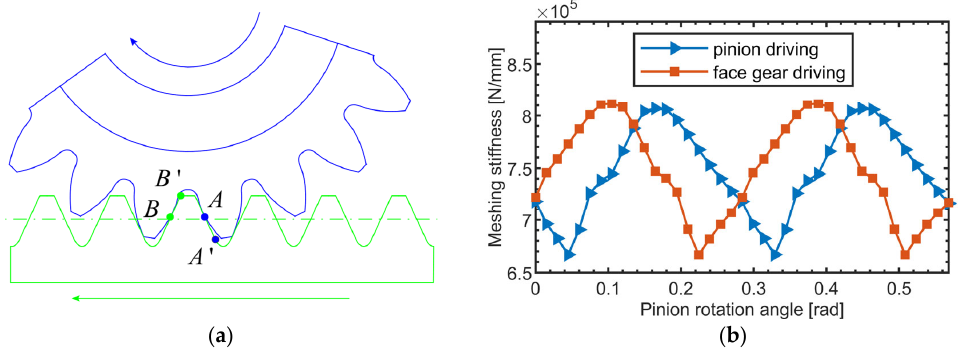
Figure 8. Di ff erence in meshing sti ff ness between face gear driving and pinion driving: ( a ) direction Figure 8. Difference in meshing stiffness between face gear driving and pinion driving: ( a ) direction of meshing; ( b ) di ff erence in meshing sti ff ness. of meshing; ( b ) difference in meshing